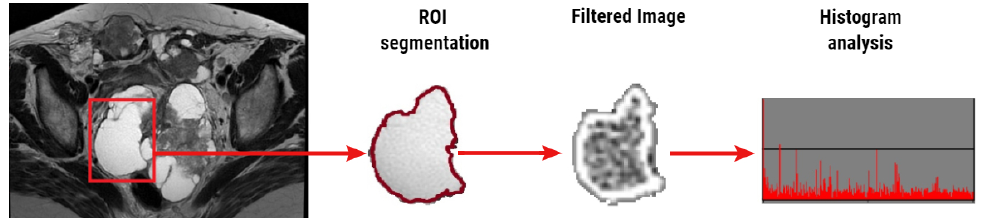
Figure 1. Illustration (workflow) of the texture analysis of a T2-weighted image (T2WI) based on